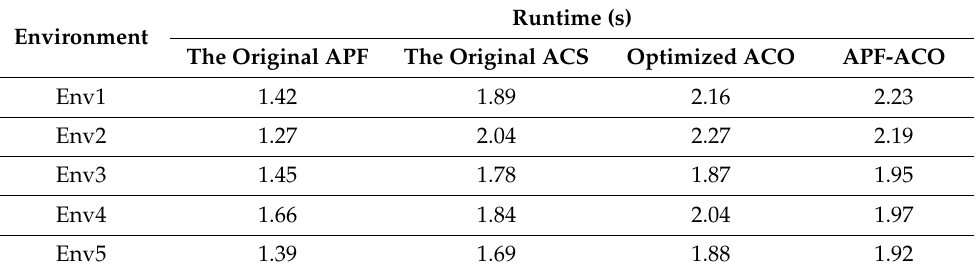
Table 5. The Runtime Comparison of the Four Algorithms.